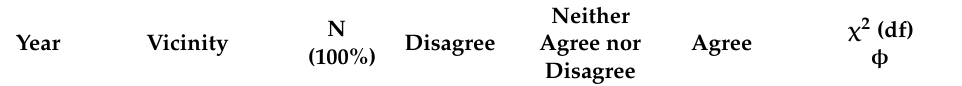
Table 5. Roman Catholics’ anti-clergy sentiments in different Lithuanian